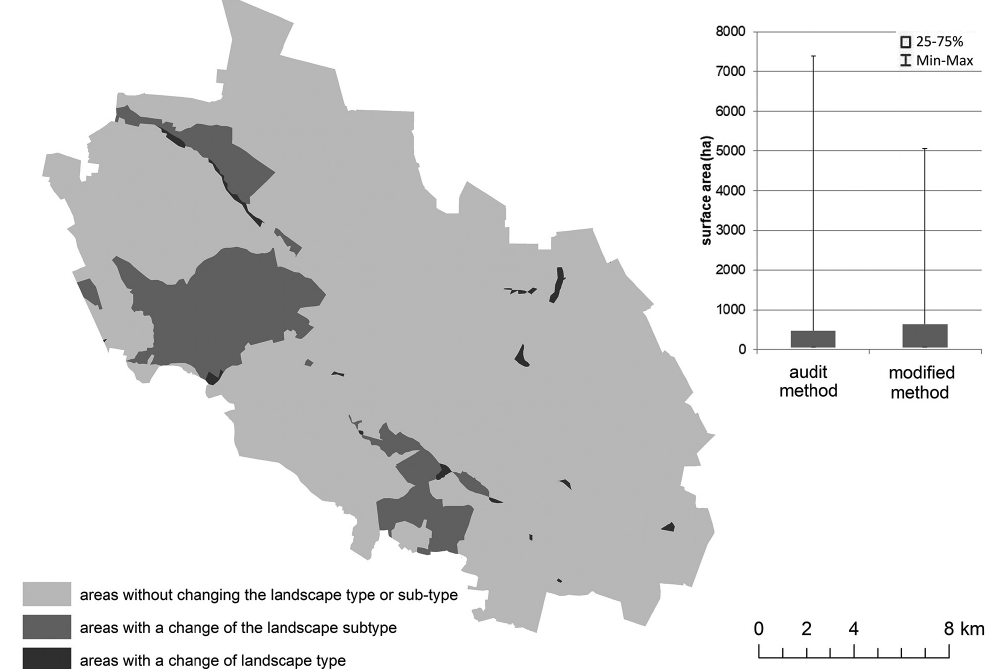
Fig. 7. Spatial range of differences in delimitated units. The graph presents the characteristic of the surface area of delimitated landscape